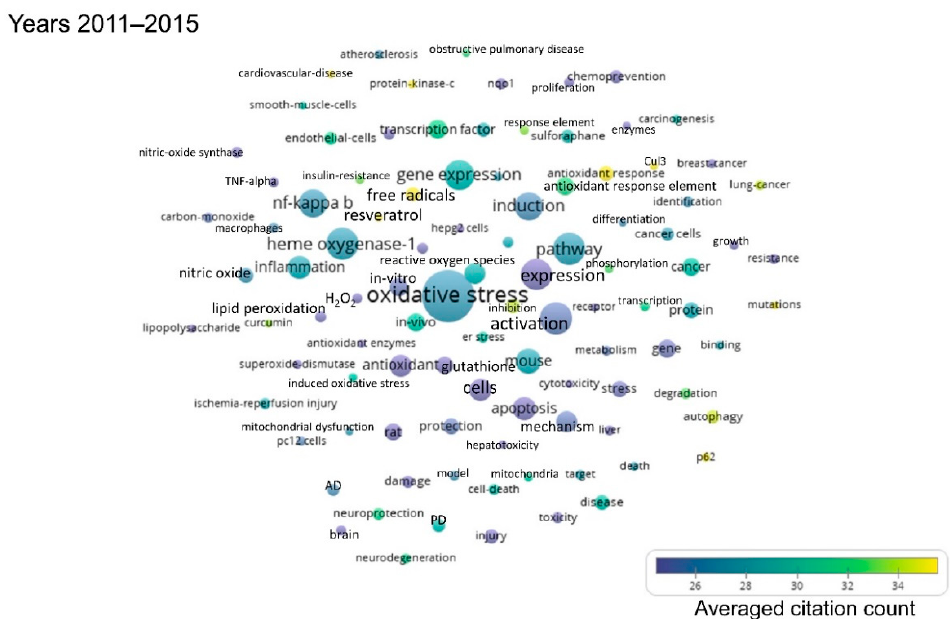
Figure 4. Term map for years 2011–2015. Bubble map showing the visualization of 100 terms that appeared in at least 50 publications published between 2011 and 2015. For explanations on bubble size, color, and proximity, see the legend of Figure 2. All the terms visualized are listed in Table S3, along with their respective occurrence frequencies and averaged citations. AD: Alzheimer’s disease, Cul3: Cul3-based E3 ligase, H 2 O 2 : Hydrogen peroxide, PD: Parkinson’s